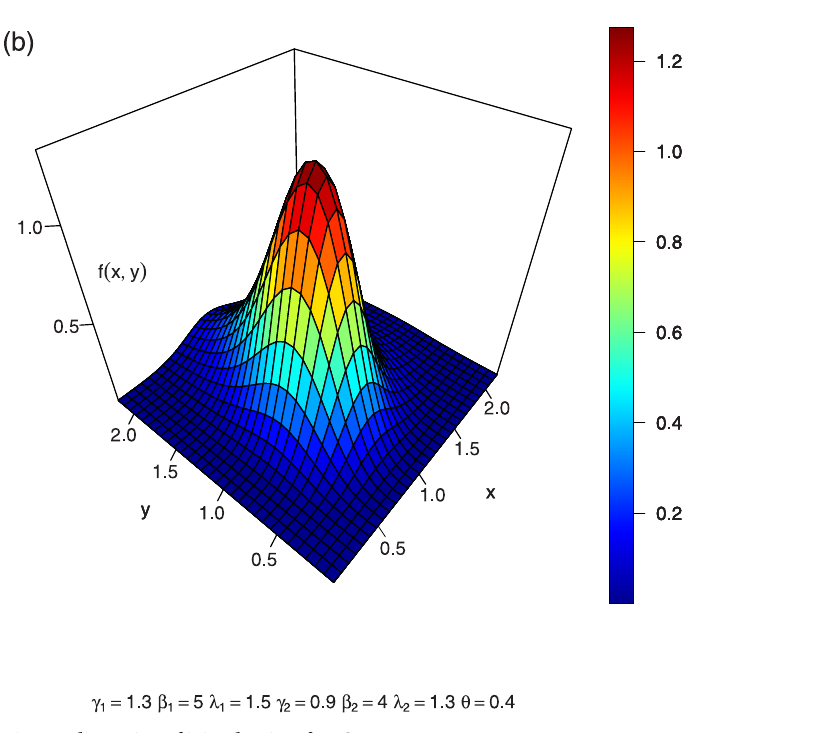
Fig 1. 3-dimension of joint density of